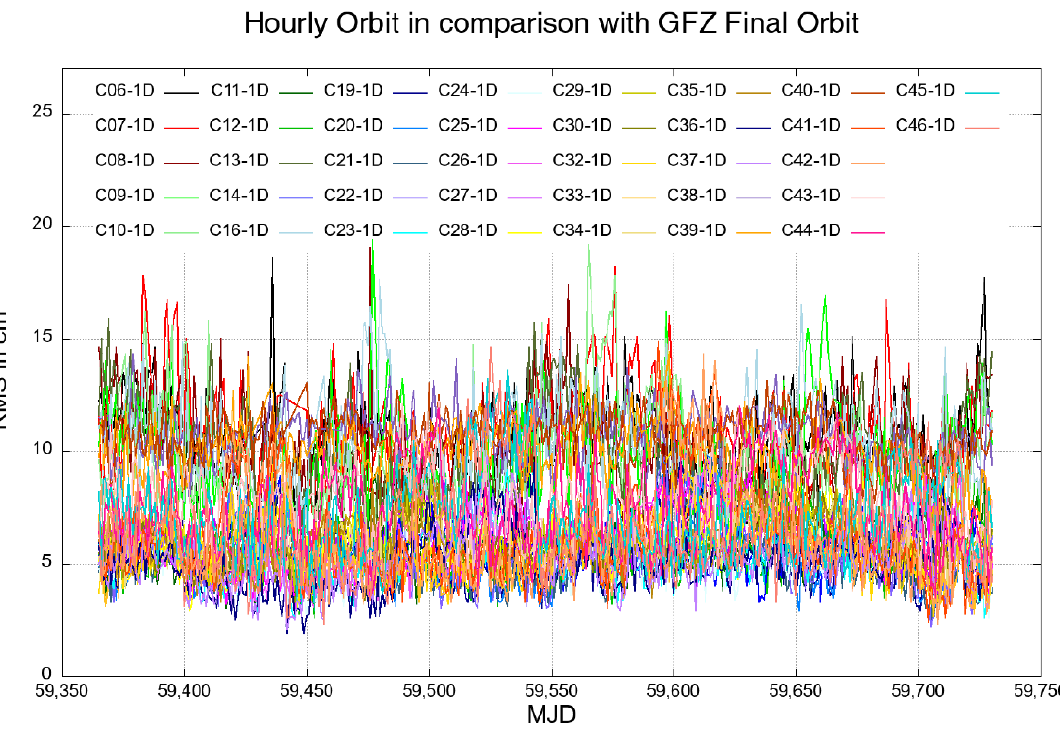
Figure 10. Time series in 1-D of BDS NONE GEO satellites compared with GFZ final orbit.